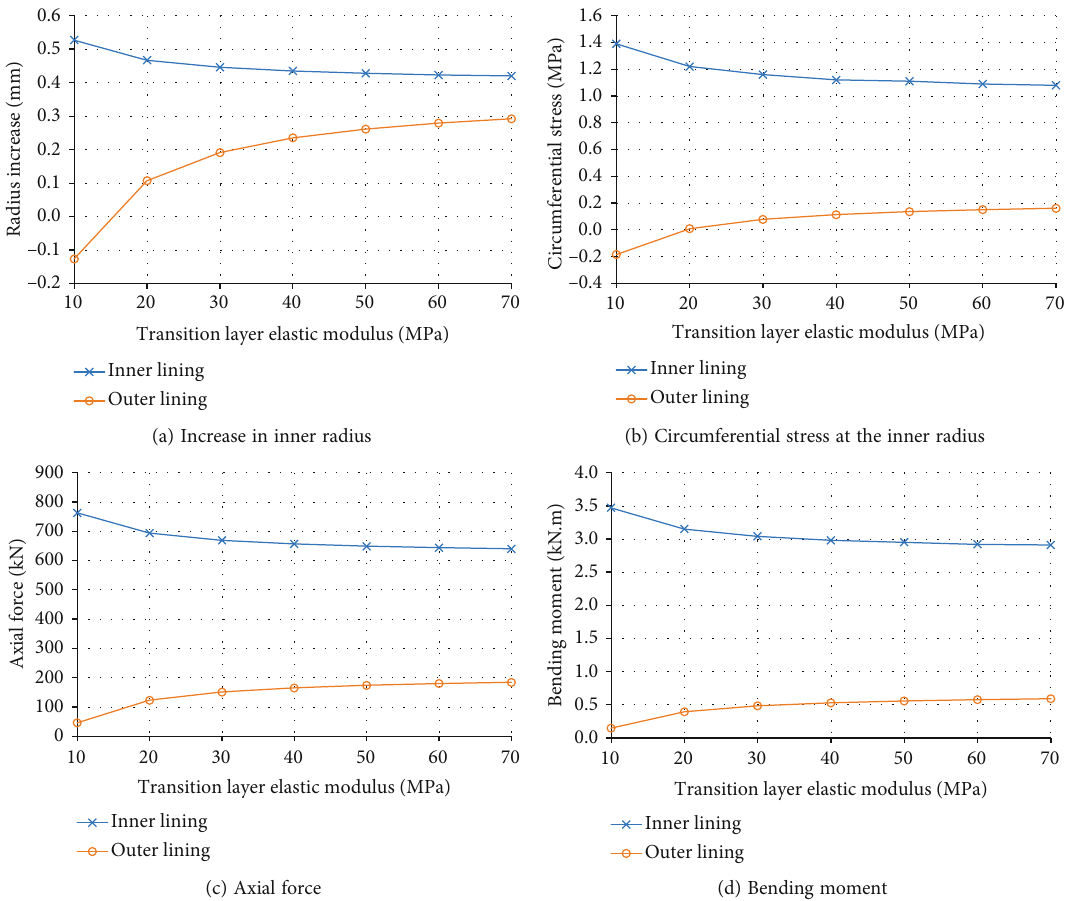
Figure 12: In fl uence of transition layer material on internal force and deformation of lining